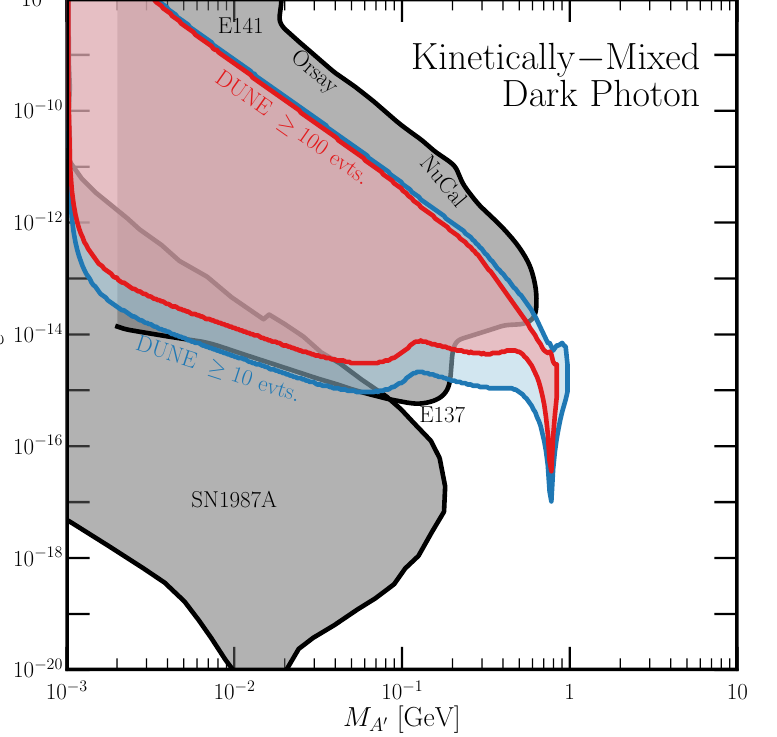
Figure 7 . Regions of parameter space of A 0 mass M A 0 vs. kinetic mixing parameter squared " 2 for which we expect 10 (100) A 0 decays in the DUNE MPD after ten years of data collection, in blue (red). Currently excluded regions are in